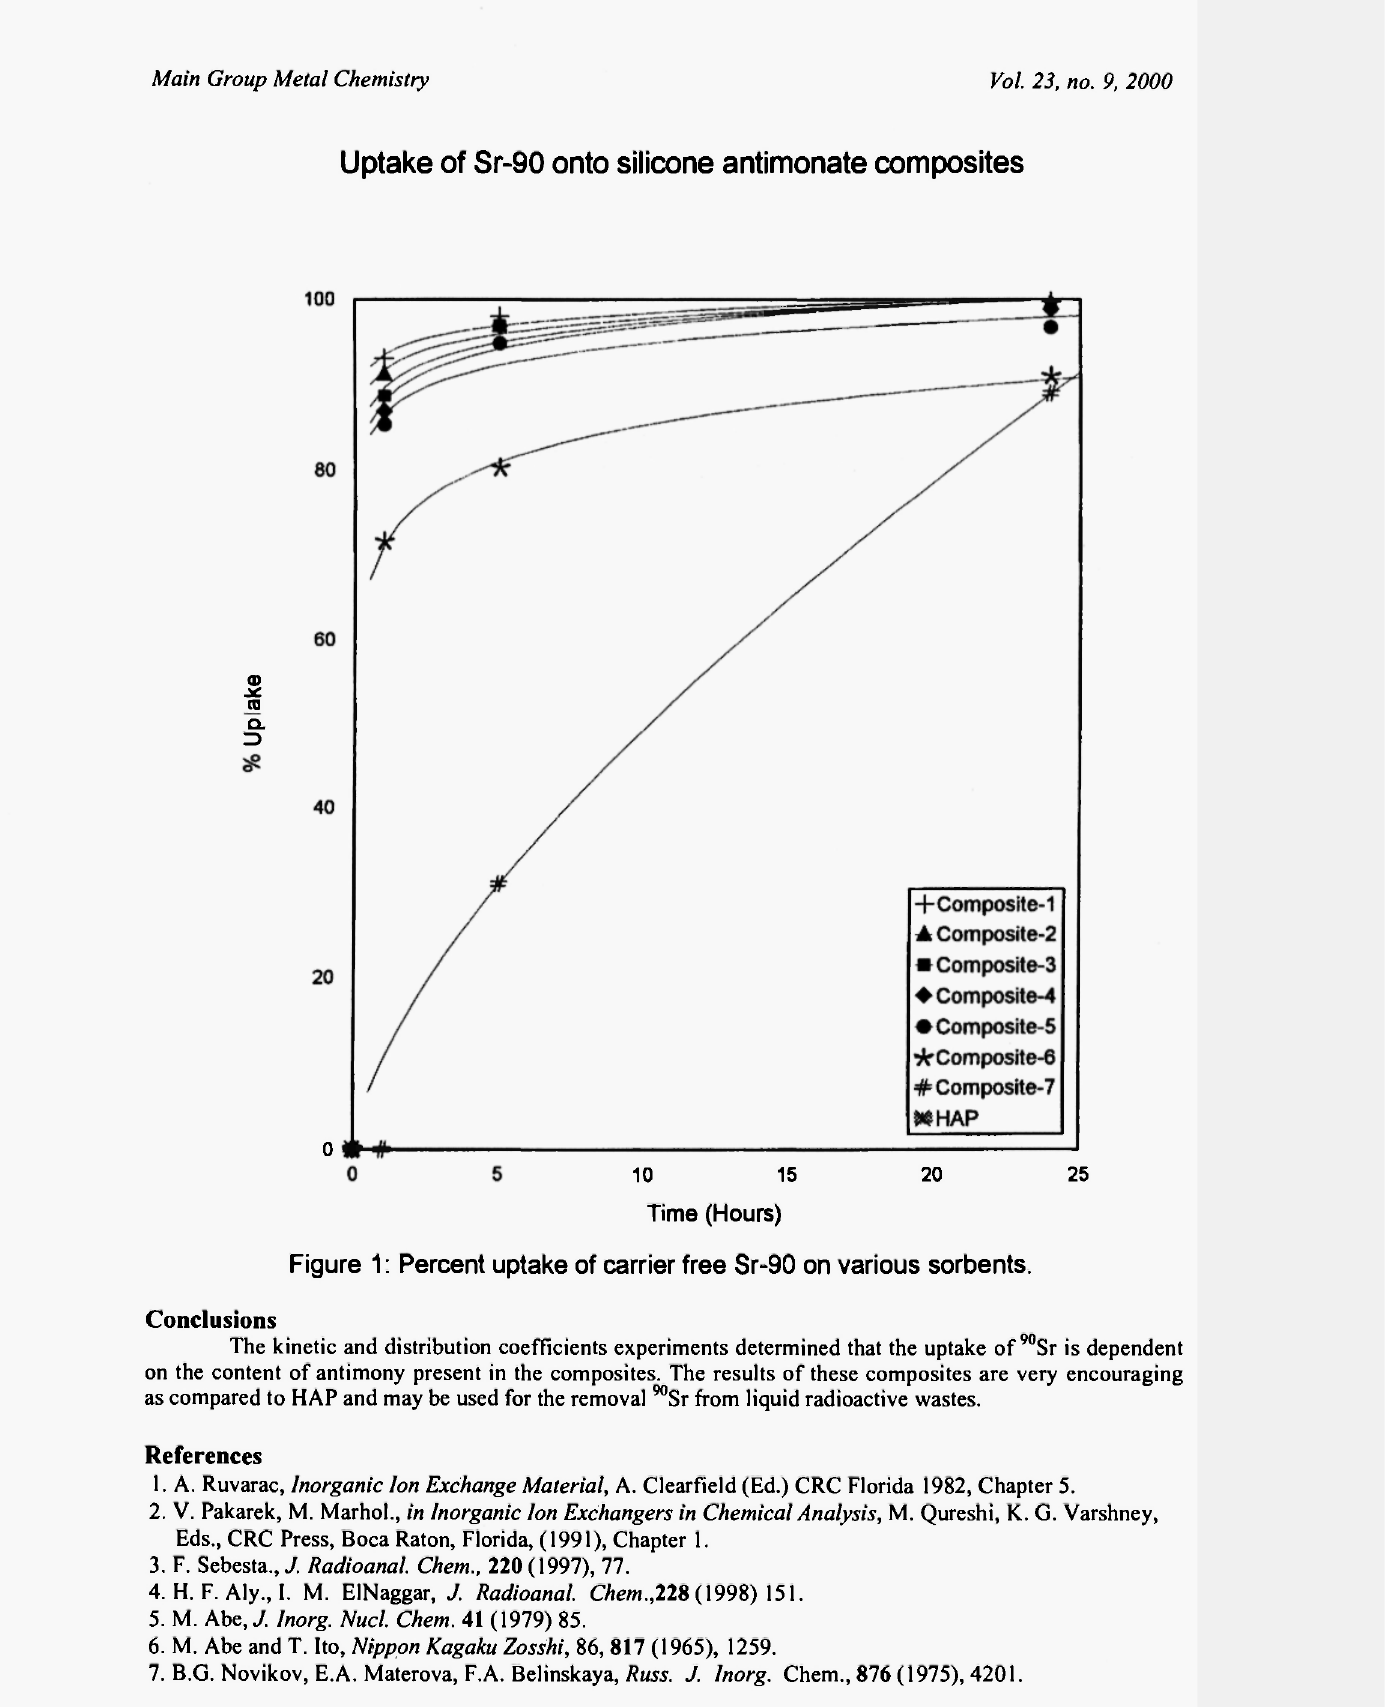
Figure 1: Percent uptake of carrier free Sr-90 on various